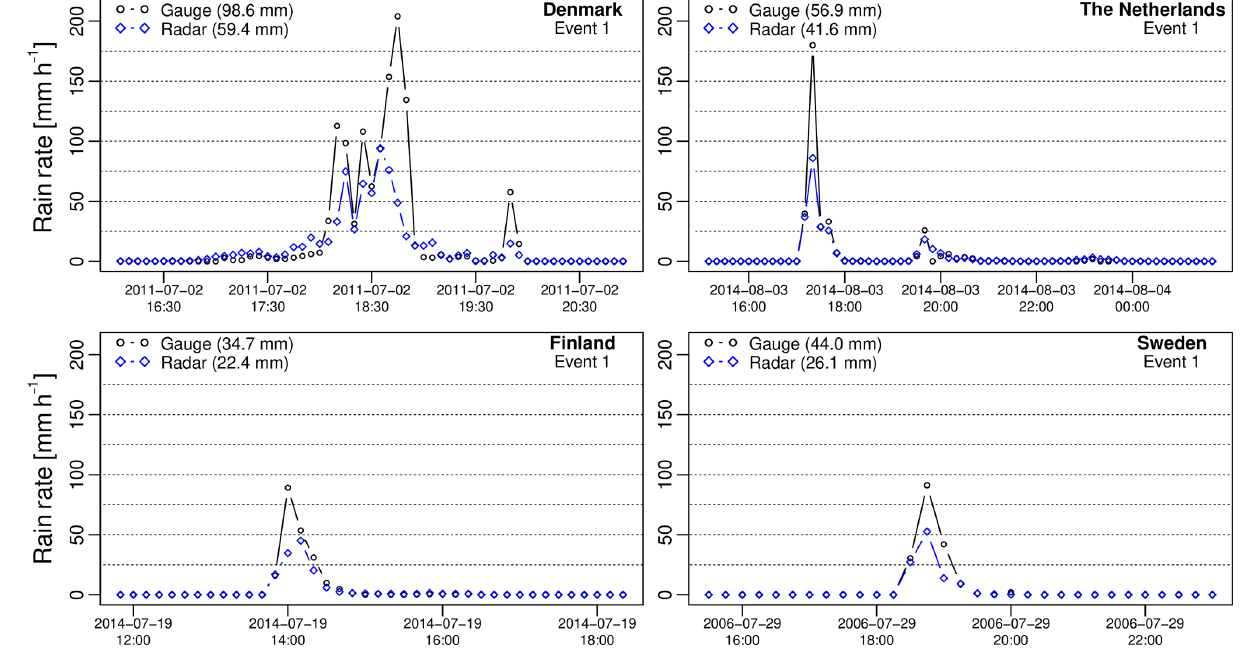
According to Eq. (5), the bias-adjustment factor e − σ 2 ε / 2